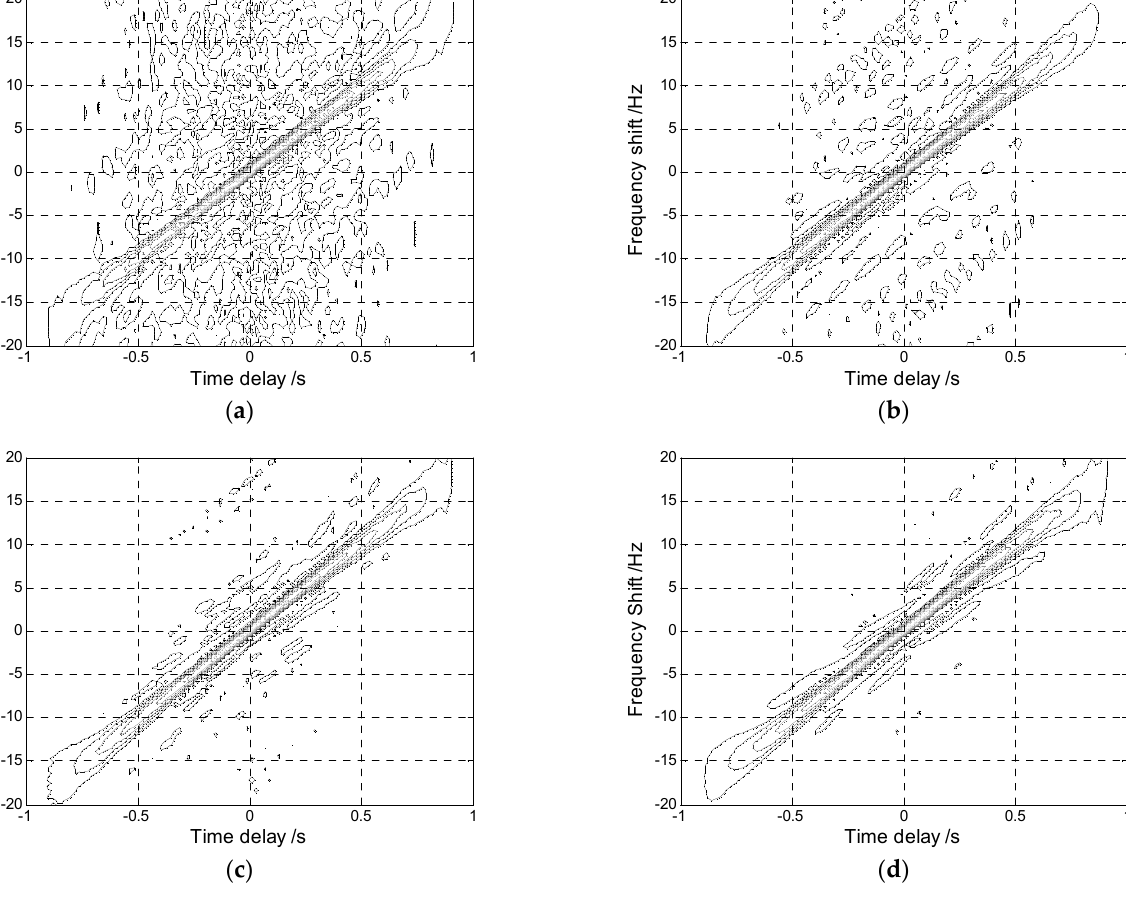
Figure 1. The time-frequency characteristic of LFM signal in S α S distribution noise with α = 1.4: ( a ) AF; ( b ) FLOAF; ( c ) CRAF; ( d ) FLOCRAF.